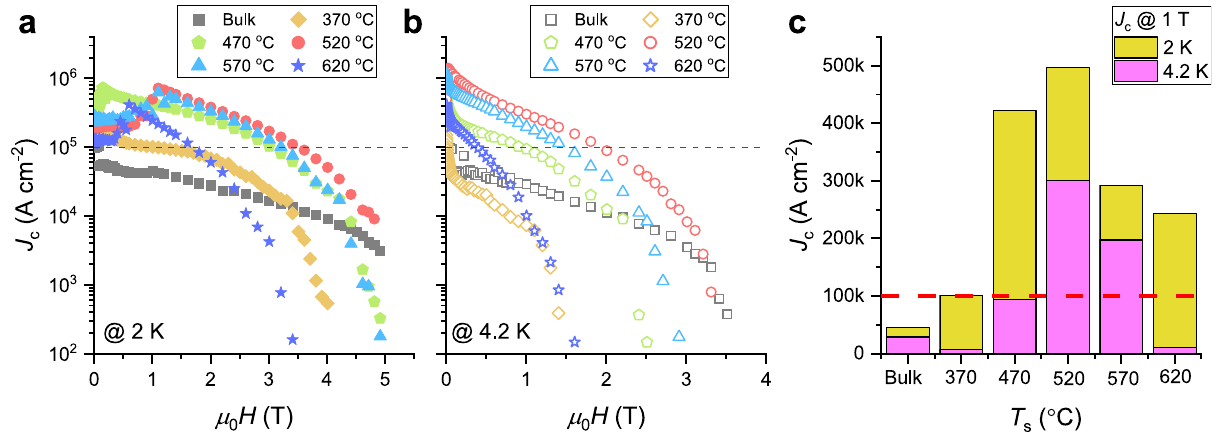
Fig. 3 Magnetic fi eld dependence of the critical current density for Ta – Nb – Hf – Zr – Ti HEA SC thin fi lms. a , b Magnetic fi eld dependence of the critical current density ( J c ) for HEA SC thin fi lms at 2.0 and 4.2 K, respectively. All the fi lms show remarkably large J c values at 0 T compared with that of the bulk HEA SC sample, as well as promising fi eld performance. The low- fi eld J c at 2.0 K is lower than that at 4.2 K because of the considerable fl ux jump at 2.0 K. The red dashed line marks J c = 100 kA cm − 2 , which is a common benchmark for large-scale applications such as high- fi eld SC magnets. c Relative levels of J c at 2.0 and 4.2 K at 1 T show that HEA superconductors are available for widespread